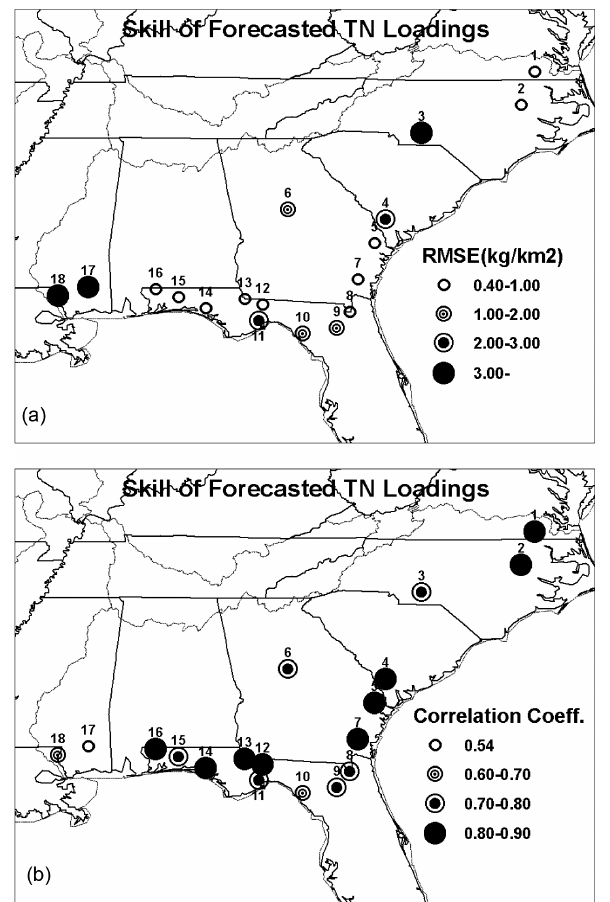
Figure 4. (a) Rank correlation and (b) RMSE between observed TN loadings and forecasted TN loadings for those days with TN loadings being available in the WQN database.